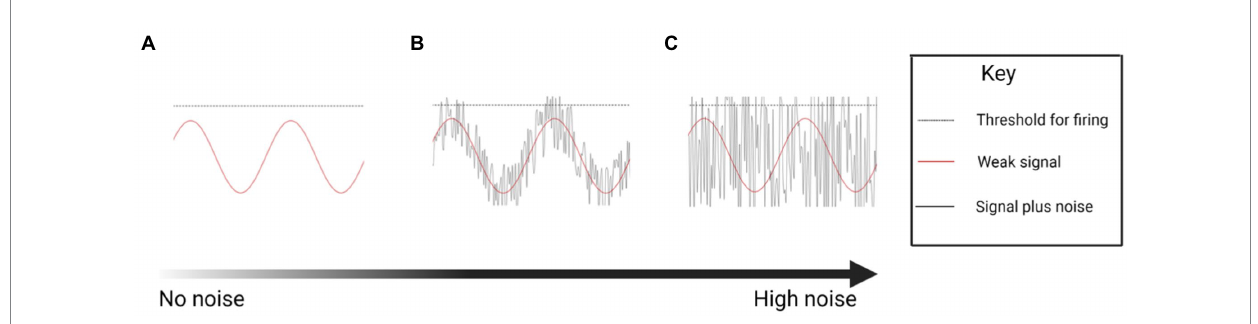
FIGURE 1 Conceptual drawing illustrating the theoretical stochastic effect of increasing levels of noise on firing of a neuron (Created with BioRender.com). (A) A sine wave in which the signal fails to reach the threshold for neural firing. (B) A sine wave enhanced by an optimum noise signal, boosting the signal past the threshold for firing. (C) Excessive noise boosts the sine wave indiscriminately, increasing neural firing, but losing the temporal